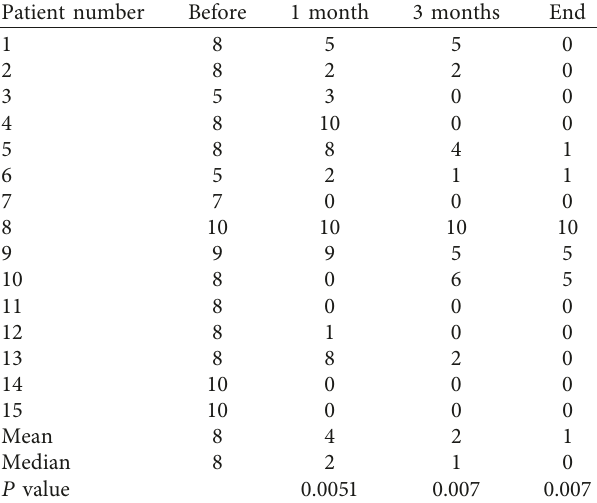
Table 2: The pain intensity in each visiting time at pain center. Patient number Before